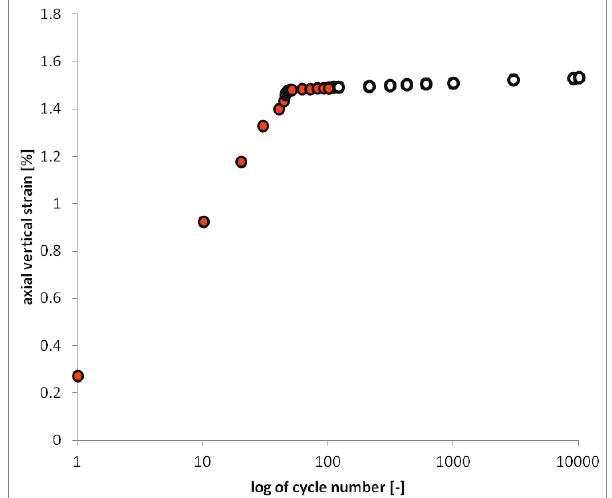
Fig. 3. Plot of detailed hysteresis loop in selected cycles during one way cyclic loading in consolidated undrained repeated loading triaxial test